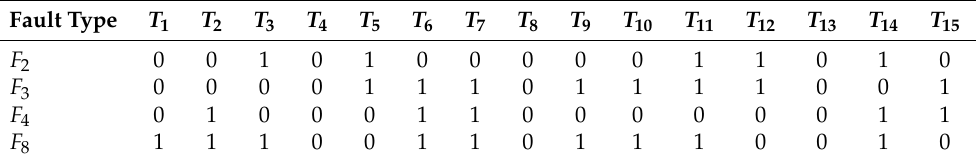
Table 10. Simplified dependency matrix of the case study in Experiment 2.